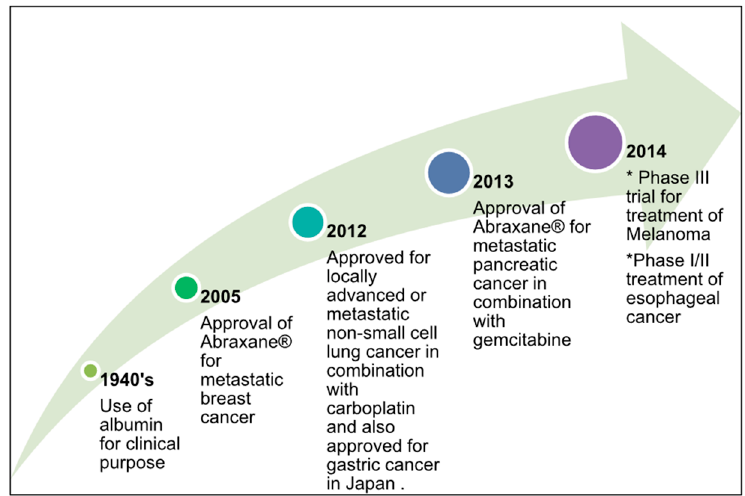
Figure 7. The successful use of albumin and an albumin nanoparticle (Abraxane) for cancer treatment [89]. Copyright © 2020, Elsevier.